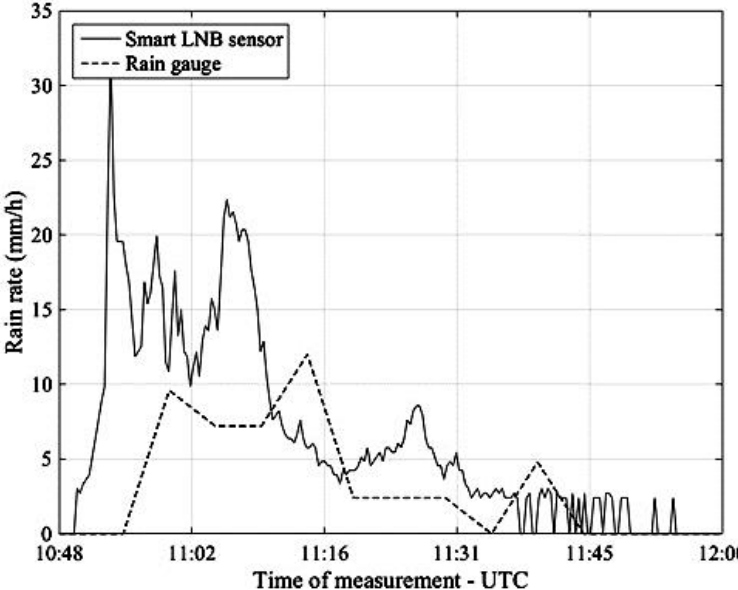
Figure 12. Pisa, 9 May 2017. Rain rate estimates provided by the NEFOCAST SmartLNB-based sensor (solid line) and by the TBR (dashed line).